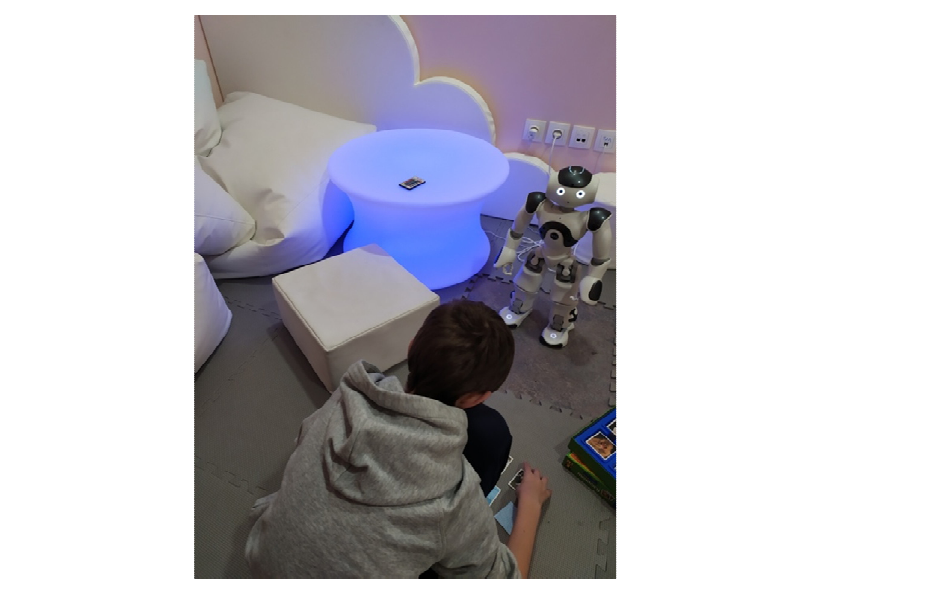
Figure 3. Positioning of child and robot in the therapy room during a session.